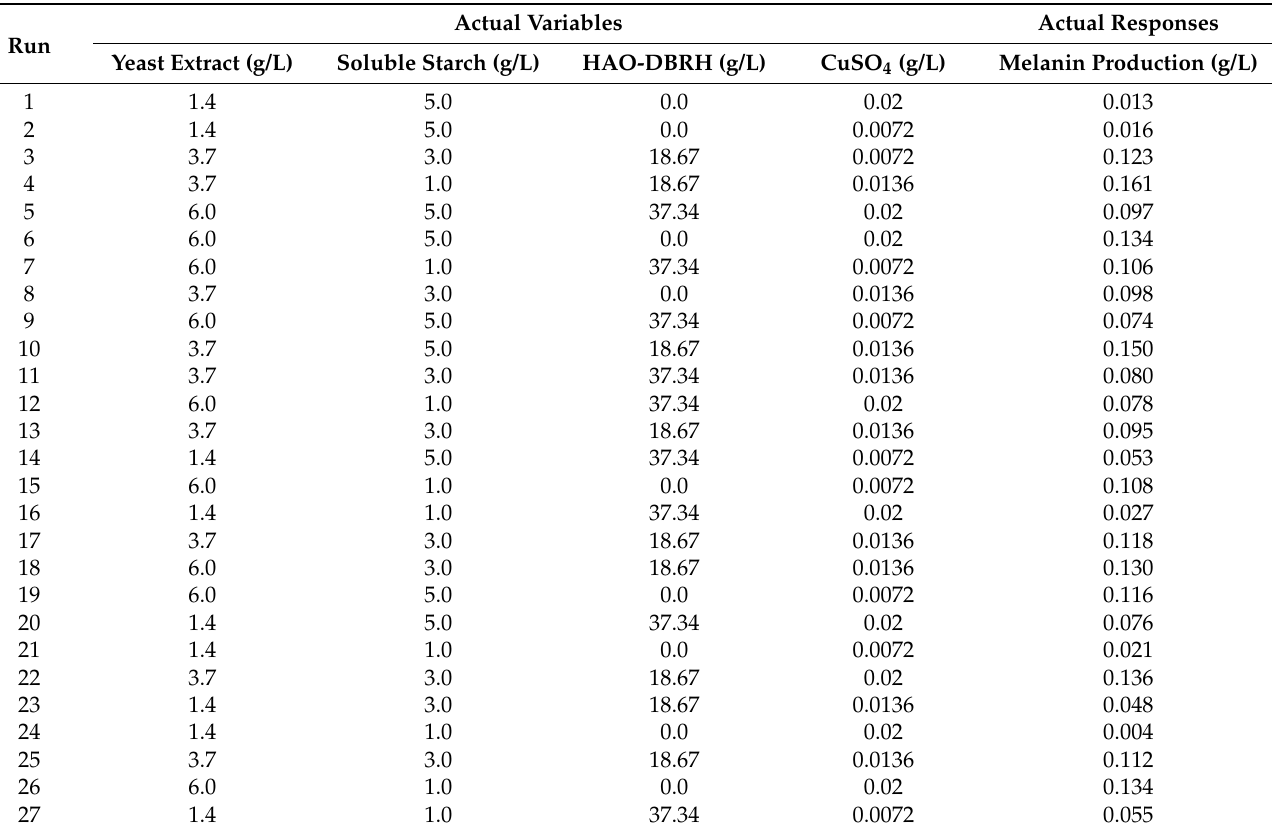
Table 3. CCD matrix and response